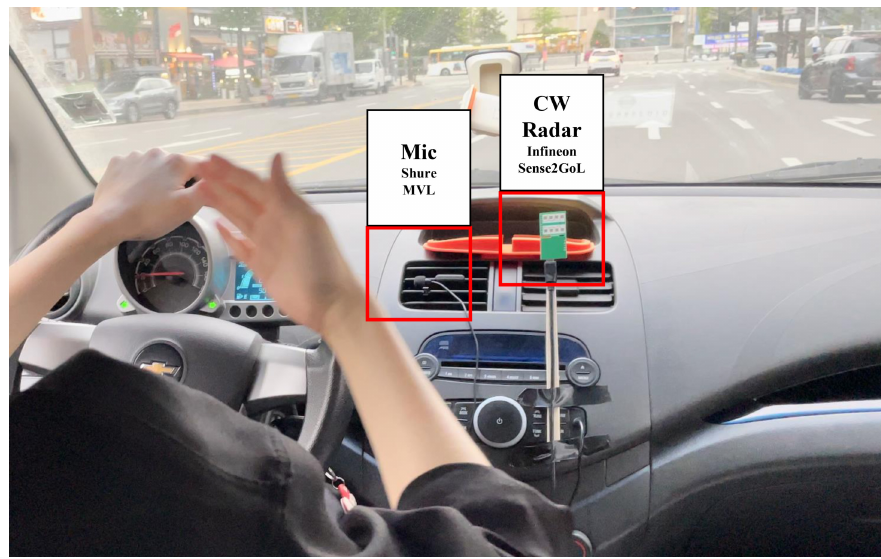
Figure 6. Experiment setup for voice and hand gesture recognition in